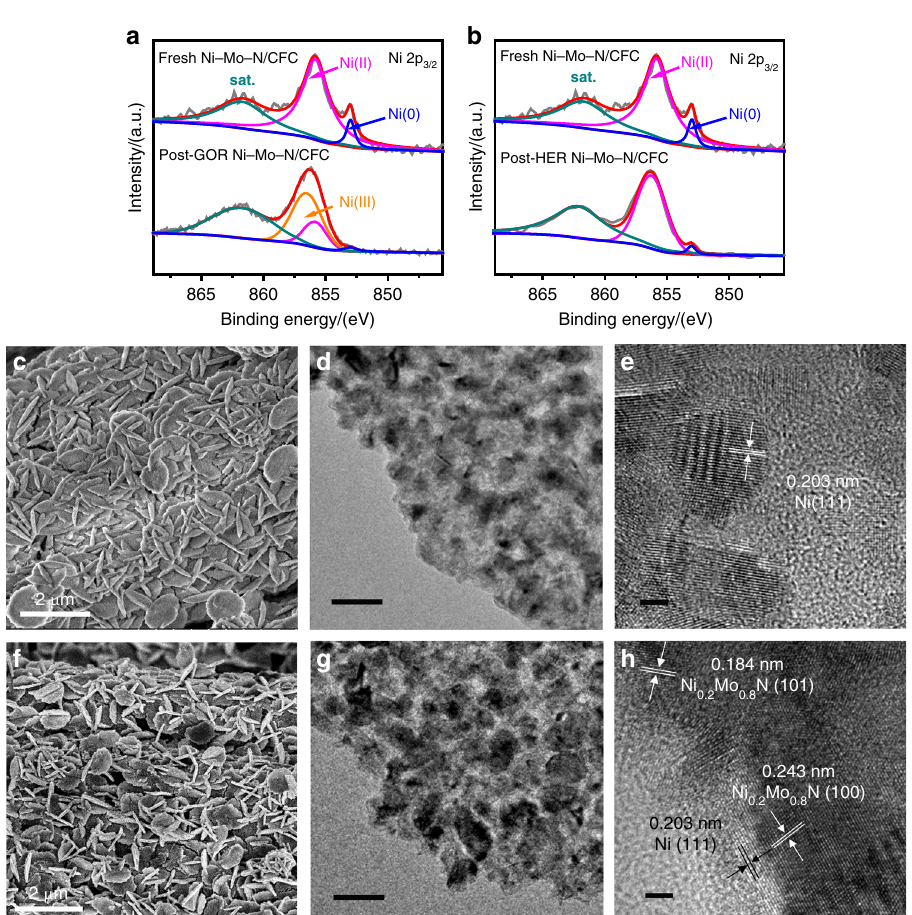
Fig. 6 Morphology and composition characterizations of Ni – Mo – N/CFC after glycerol oxidation and HER. a High-resolution Ni 2p 3/2 XPS spectra of Ni – Mo – N/CFC before and after glycerol oxidation at the anode. b High-resolution Ni 2p 3/2 XPS spectra of Ni – Mo – N/CFC before and after HER at the cathode. c SEM, d TEM, and e HRTEM images of the anodic post-GOR Ni – Mo – N/CFC. f SEM, g TEM, and h HRTEM images of cathodic post-HER Ni – Mo – N/CFC. Scale bars, c 2 µ m; d 50 nm; e 2 nm; f 2 µ m; g 50 nm, h 2